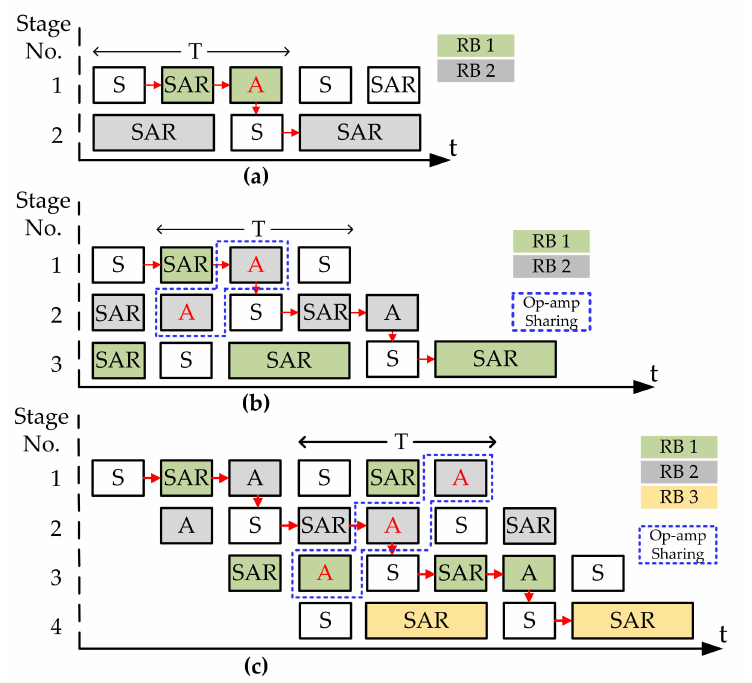
Figure 6. The timing diagram of pipelined-SAR ADCs with ( a ) two stages, ( b ) three stages, and ( c ) four stages. In each timing diagram, the signal flow is represented with red arrows. The blue dashed box means that the amplification in different phases is finished with a shared op-amp. The needed reference buffer is marked with different